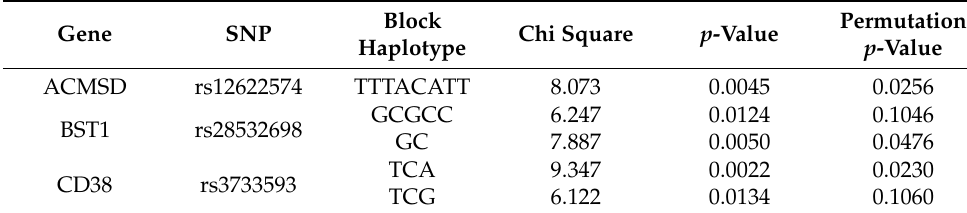
Table 4. Haplotype Analysis results of significant SNPs.